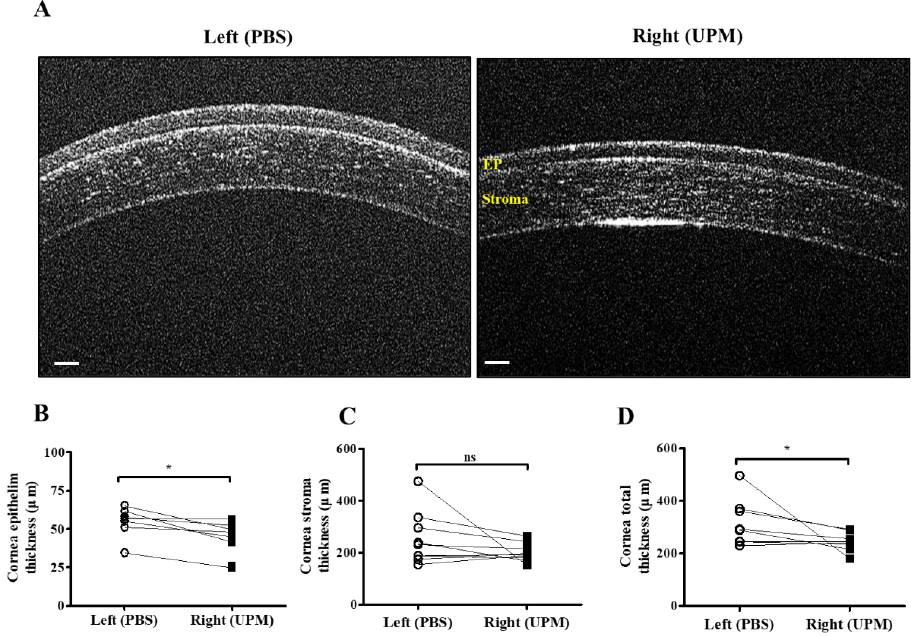
Figure 4. Corneal thickness analysis by SD-OCT at 16 weeks of UPM exposure. ( A ) Images of corneas acquired by SD-OCT are shown. Each layer is marked by yellow letters. The scale bars indicate 100 µ m. Direct comparisons of the thickness of the epithelium ( B ), the stroma ( C ) and the total layers ( D ) between the left and right eyes determined by SD-OCT software at 16 weeks are presented. * p < 0.05 vs. left eye. EP, epithelium. ns, not significant.